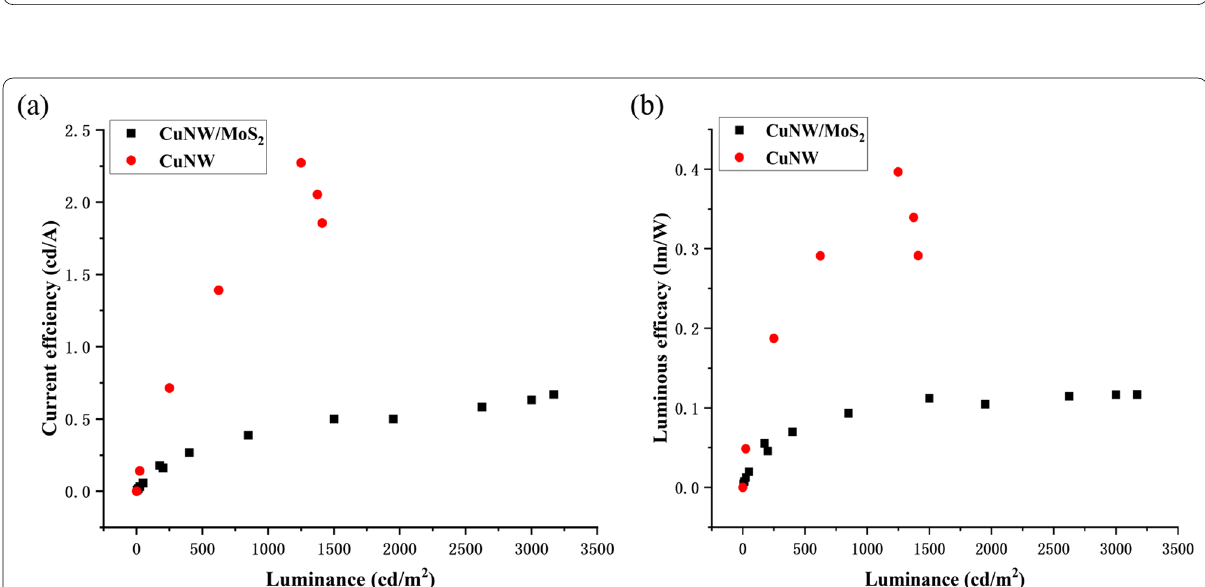
Fig. 11 Current efficiency and power efficiency of the OLED with MoS 2 anode buffer layer and the OLED without MoS 2 anode buffer layer: a current efficiency, b power